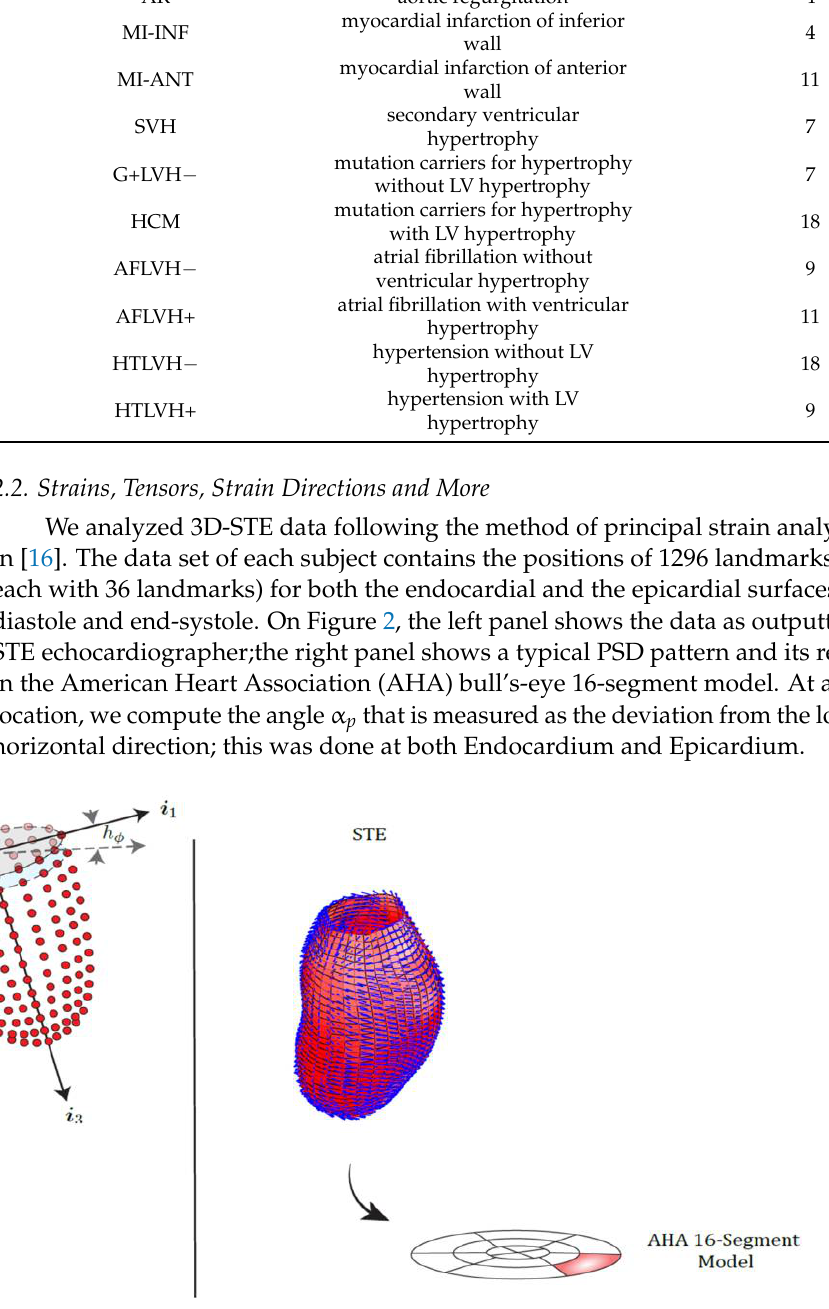
Figure 2. The 3D-STE can track the position of thousands of landmarks during the heart’s cycle. ( Left Panel ) Left: Typical 3D-STE landmarks output, i.e. the discretization of LV surfaces using the position of the landmarks tracked by the 3D-STE; each LV surface is segmented in 36 planes along the axial direction (base to apex); planes are equally divided into 36 sections along hoop direction. ( Right Panel ) Top: Example of PSD patterns as evaluated by using the original 3D-STE data. Bottom: PSD orientations and PSs are displayed on the American Heart Association (AHA) bull’s-eye 16-segment model. Modified from [19].